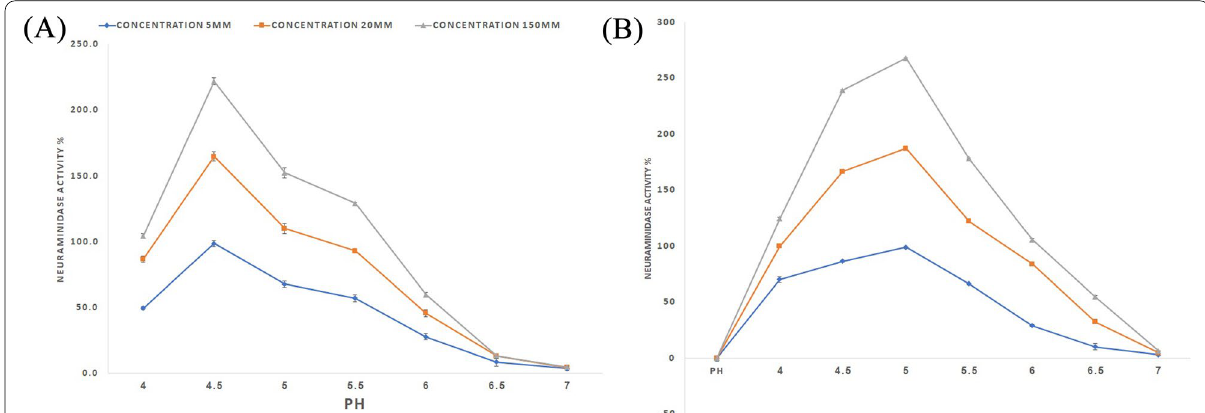
Fig. 9 Neuraminidase activity of HN protein is pH and chloride-dependent. A Activity of purified recombinant HN protein in the presence of 5 (“”, •blue line), 20 (“ ■ ”, orange line) and 150 (“ ◄ ”, grey line) mMNaCl. B Activity of native HN from viral lysate in the presence of 10 (“•”, blue line), 90 (“ ■ ”, orange line) and 160 (“ ◄ ”, grey line)